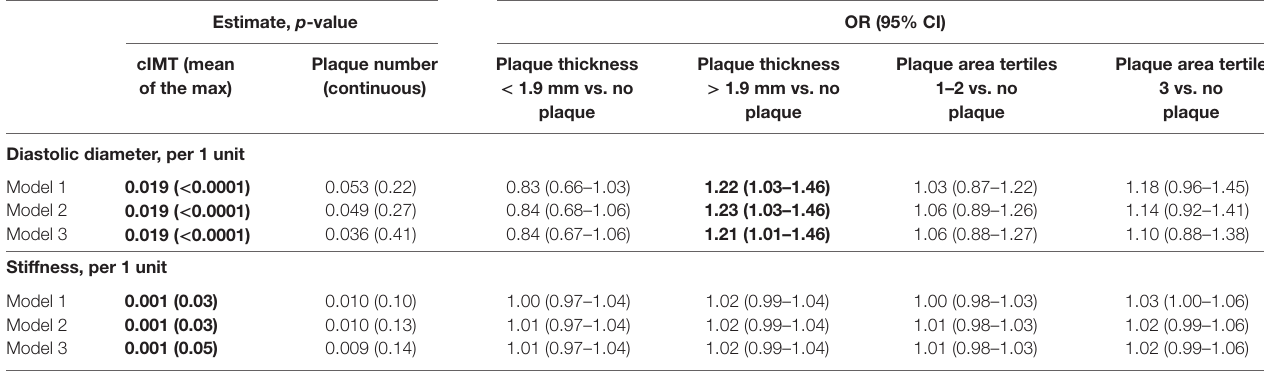
Model 1: controlling for demographics (age, sex, and race/ethnicity). Model 2: controlling for demographics and anti-hypertensive medication use. Model 3: controlling for demographics, anti-hypertensive medication use, smoking, diabetes, hypercholesterolemia, moderate alcohol use, moderate-heavy physical activity, and BMI. Significant associations and corresponding p values (p < 0.05) are in bold to aid the viewer.